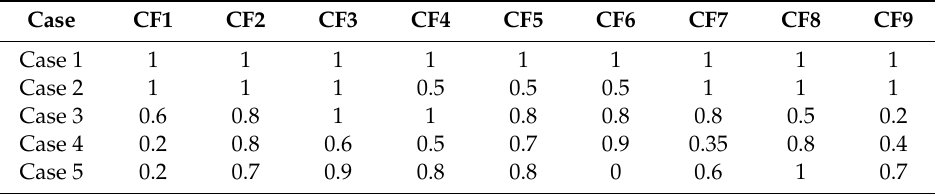
Table 8. Certainty grade values of the fuzzy rule for a di ff erent case.